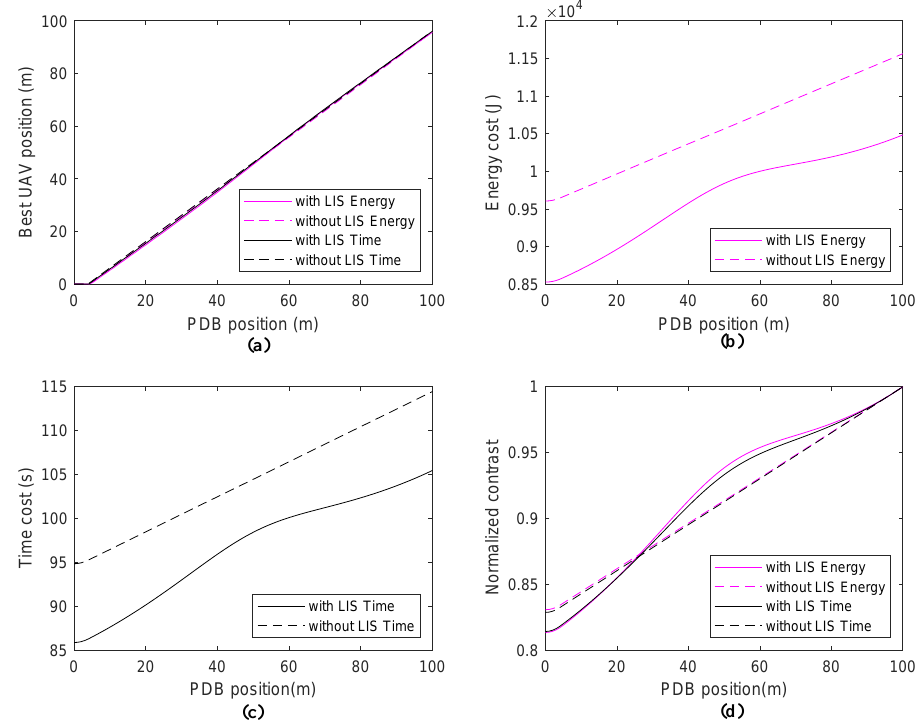
Figure 9. Relationship between the best UAV position and single PDB position in Scene II : ( a ) best UAV position, ( b ) energy cost, ( c ) time cost, and ( d ) normalized